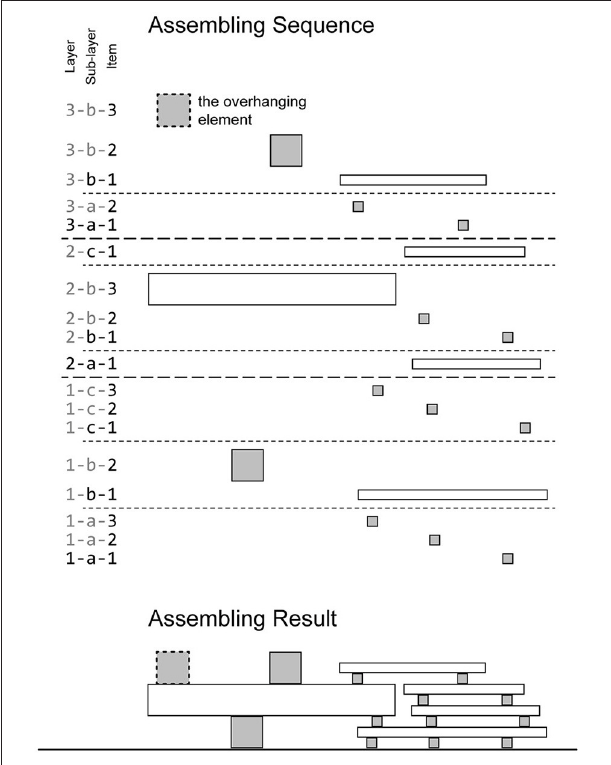
FIGURE 5 | Assembly of layers and sub-layers follows a sequence that is allowing hang over condition and combination of larger and smaller elements.